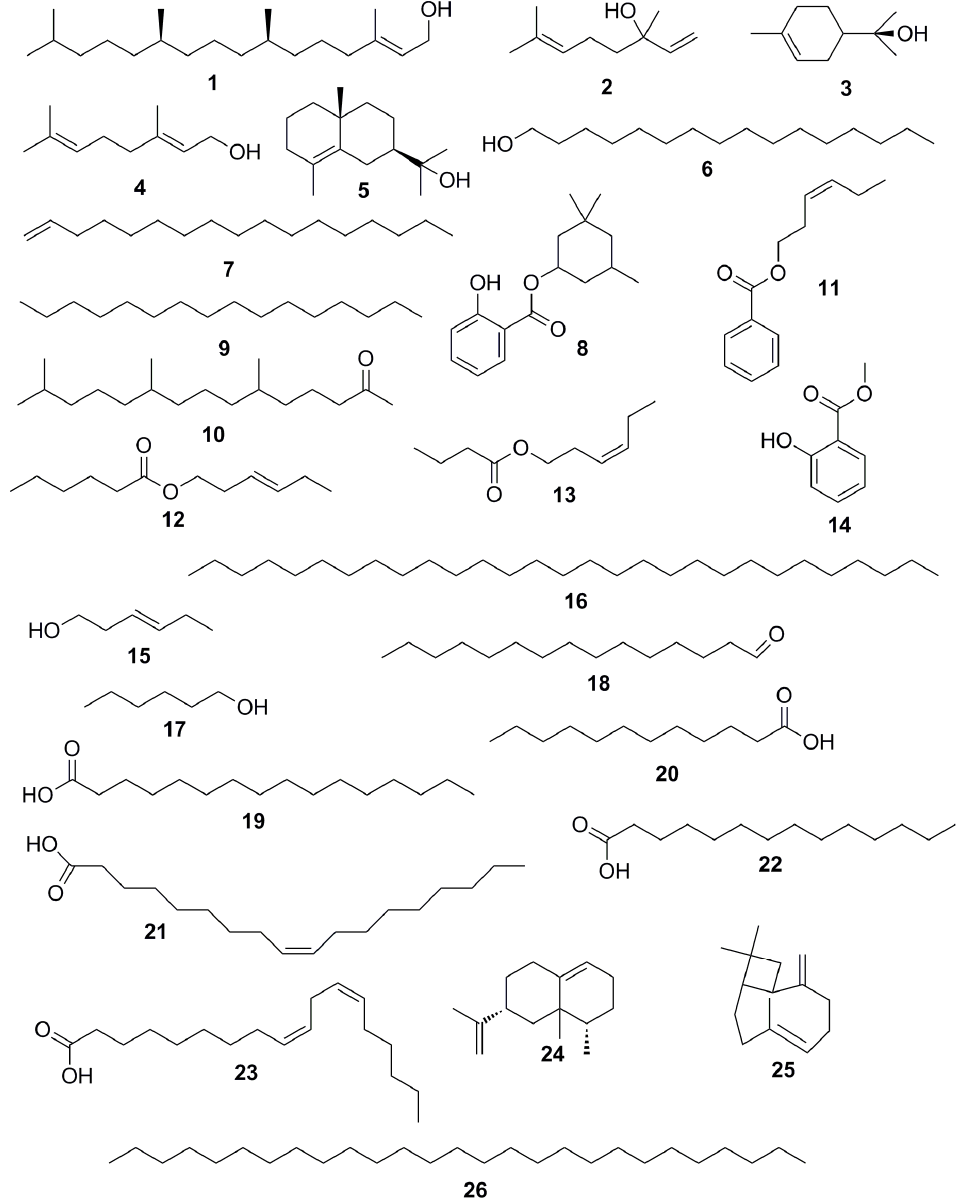
Figure 1. Structures of some compounds identified in the essential oils from I.